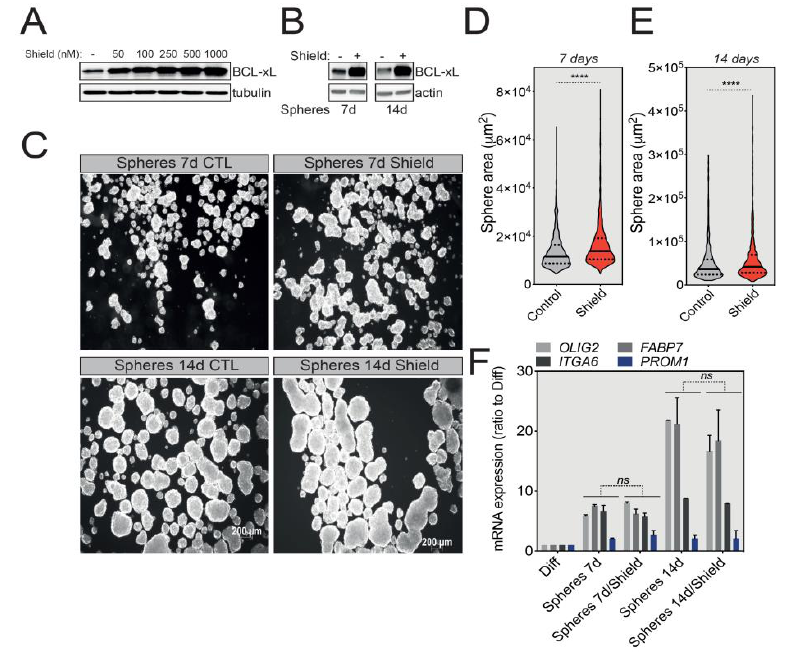
Figure 3. BCL-xL overexpression increases the size of U-87 MG-derived tumorspheres. ( A ) Western blot analysis correlating the expression of BCL-xL with the concentration of Shield-1 ligand used to treat U-87 MG BCL-xL DD cells for 24 hours. Full-length blots are presented in Figure S4. ( B ) Western blot analysis of BCL-xL overexpression in U-87 MG tumorspheres after 7 and 14 days of Shield-1